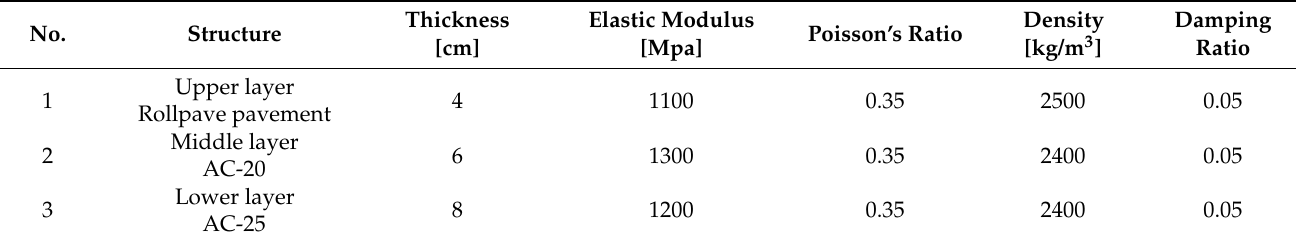
Table 3. Pavement structure and material